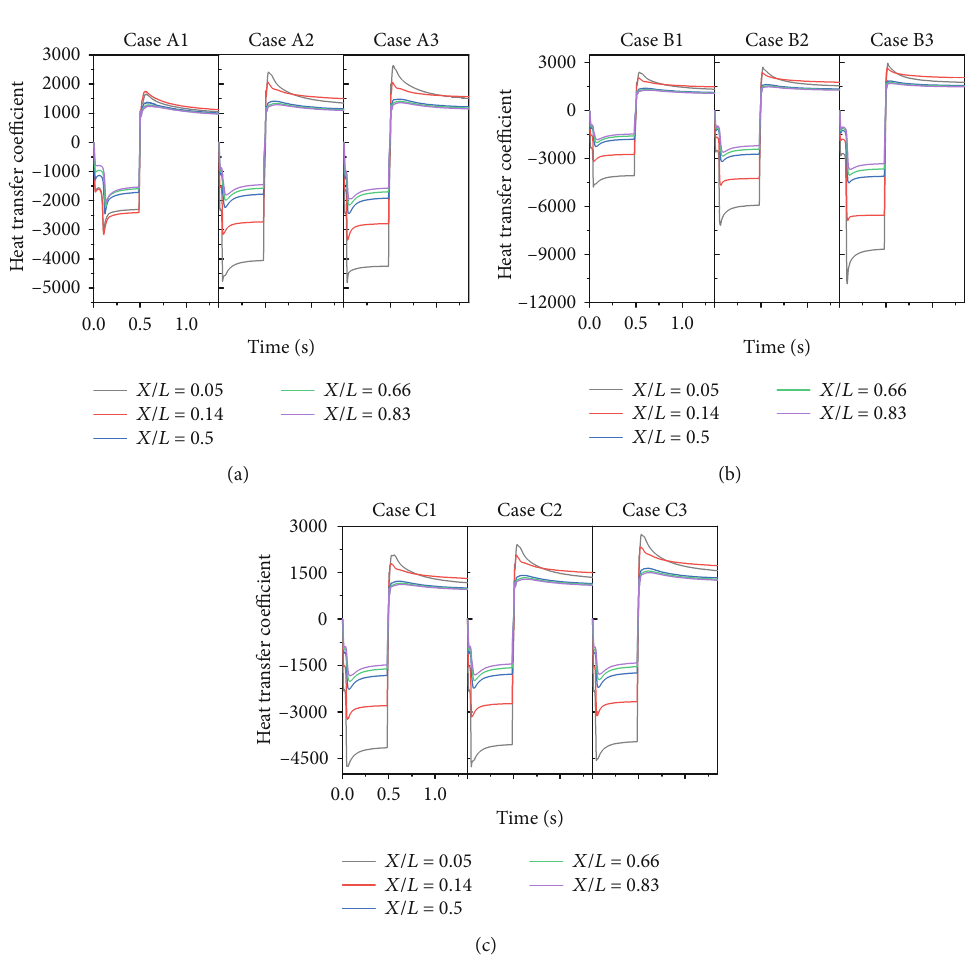
Figure 13: Time trace of heat transfer coe ffi cients for the cases with di ff erent inlet conditions.